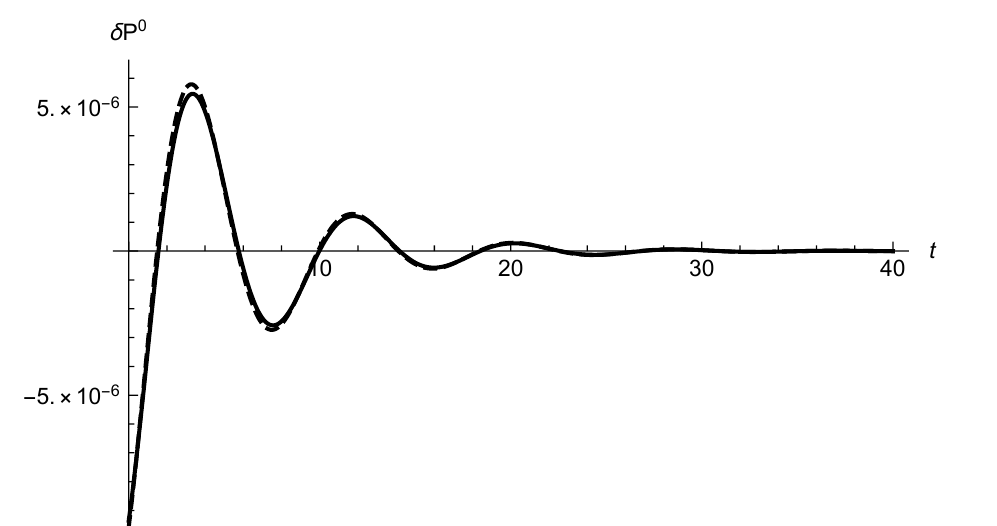
Figure 2. Comparison between the real parts of the gravitational energy of the axial perturbation, as a function of time. The continuous line represents the values of the numerical integration of the energy, whereas the dashed line represents the values obtained from the approximate analytic expression (34). The parameters used are A = 10 − 6 , m = 1. The frequency was required to be the fundamental frequency ( n = 0, l = 2) ω = 0.373162 − i 0.089217, obtained from the third-order WKB method. The radius of integration was chosen to be r = 60, in natural